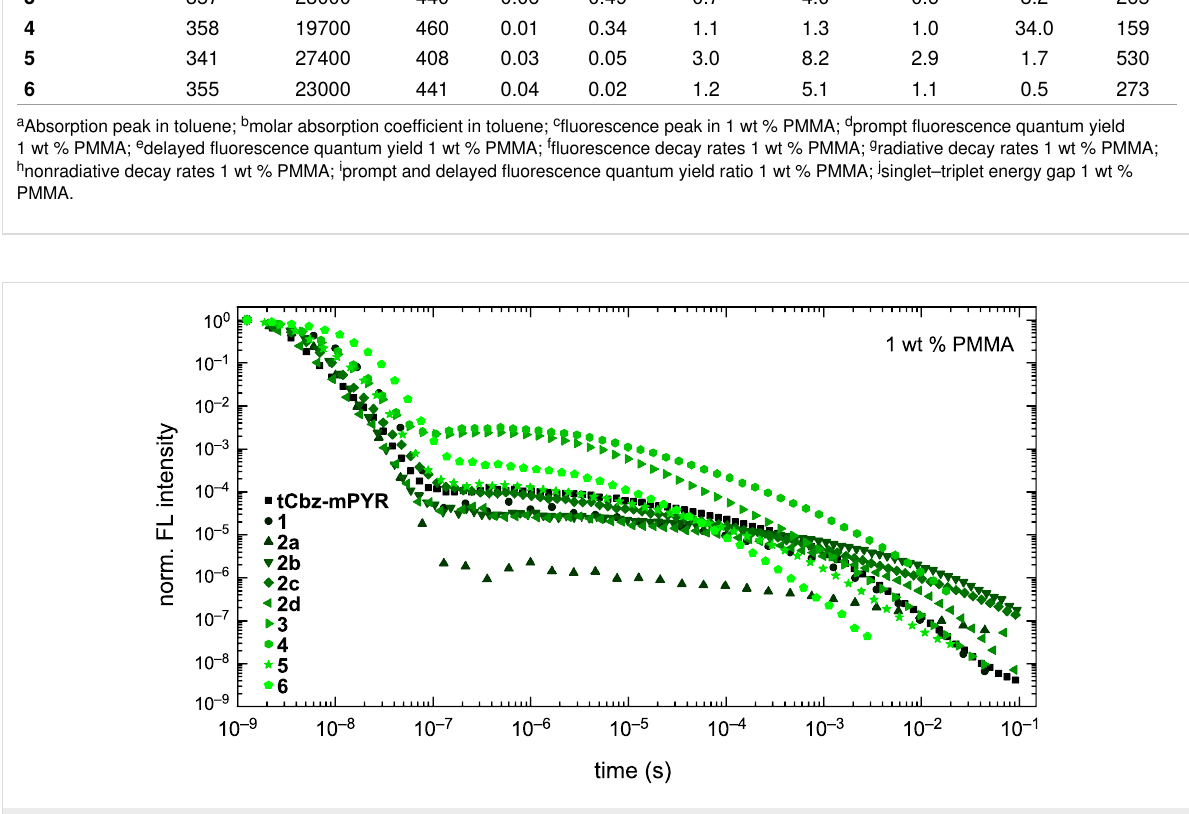
led to lower Φ DF , probably due to the enlarged nonradiative decay rate. Interestingly, Δ E ST was remarkably larger for tCbz - mPYR despite its high Φ DF . In this case, rISC probably